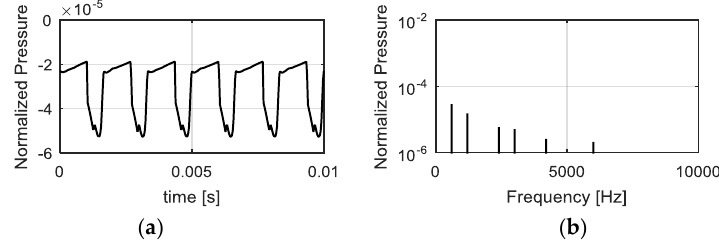
Figure 9. Inlet pressure ripple depending on time ( a ) and frequency ( b ).